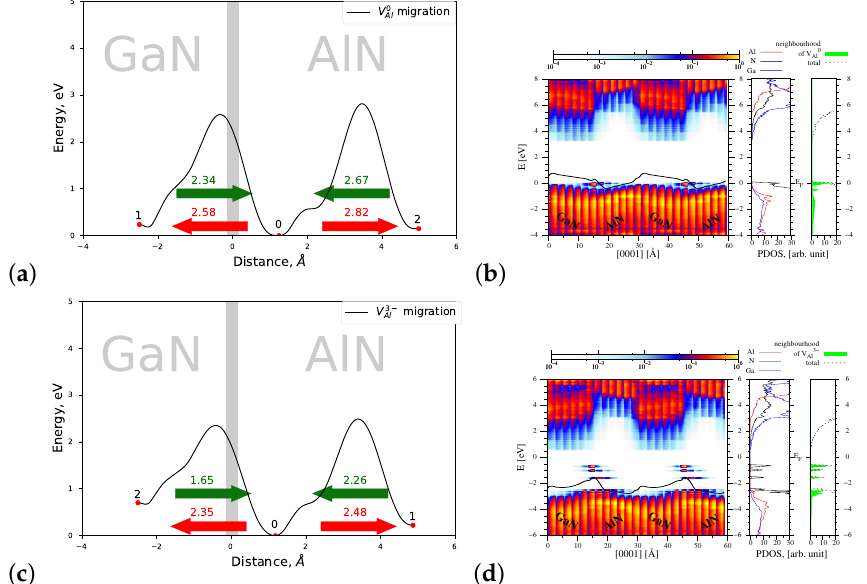
Figure 6. Left—joint profiles of the migration energy barriers of aluminium vacancy V Al at the AlN/GaN strained interface type, right—the density of states projected on the atom quantum states (PDOS), showing the spatial variation of the valence and conduction bands in the GaN/AlN heterostructure, as well as the total DOS and PDOS functions associated with Al, N, and Ga atoms, denoted by red, black, and blue lines, respectively. The green shade represents a sum of the PDOS from the nearest neighbors of V Al . ( a , b ) V 0 , the corresponding potential jump ∆ V = 0.75 eV ( c , d ) Al V 3 − , the corresponding potential jump ∆ V = 0.58 Al